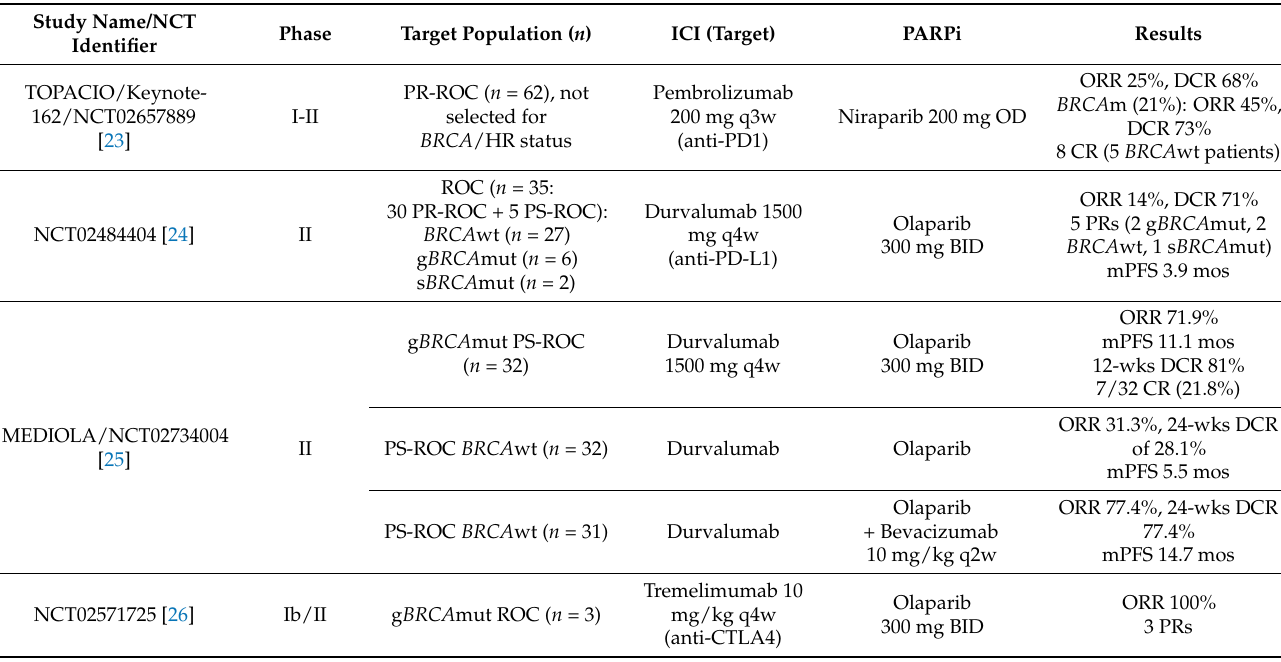
Table 1. Clinical trials of PARPis plus ICIs combination in OC with published